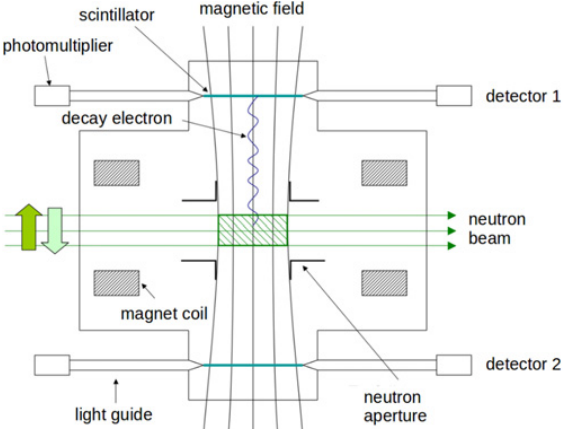
Figure 1. Drawing of the P ERKEO II spectrometer. A magnetic field of about 1T transports decay electrons to the detectors. Besides backscatter events normal beta decay electrons will reach only one detector, while e + e − -pairs will trigger both detectors, if emitted towards opposite detectors.